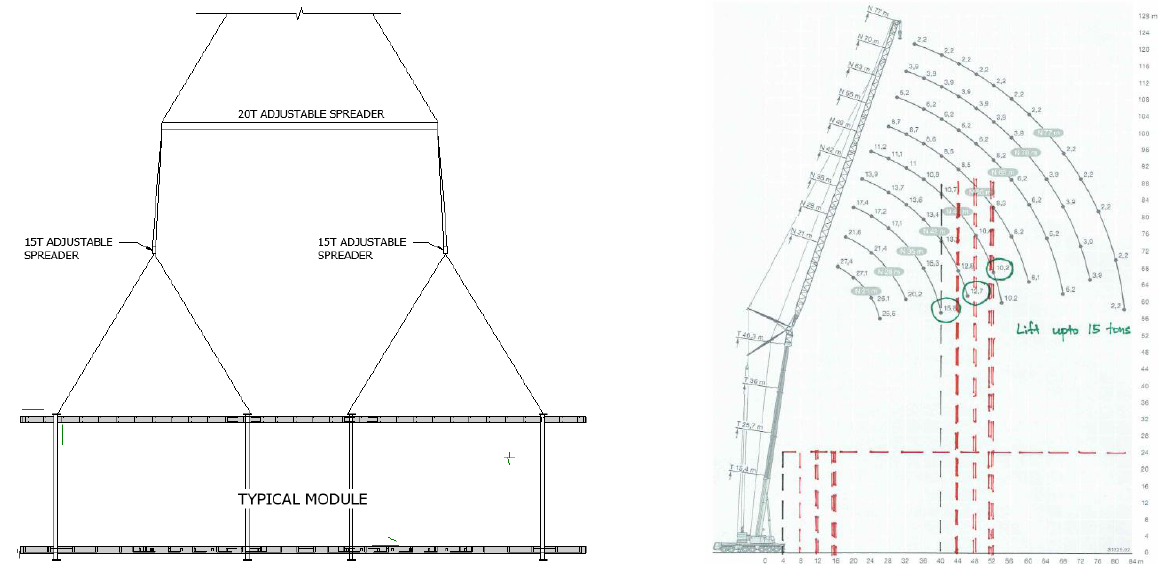
Figure 6. The lifting design of a prefabricated volumetric module where a top lift with an adjustable spreader is designed ( left ) and the lifting capacity for a mobile crane is worked out using lifting angles and distances ( right ).